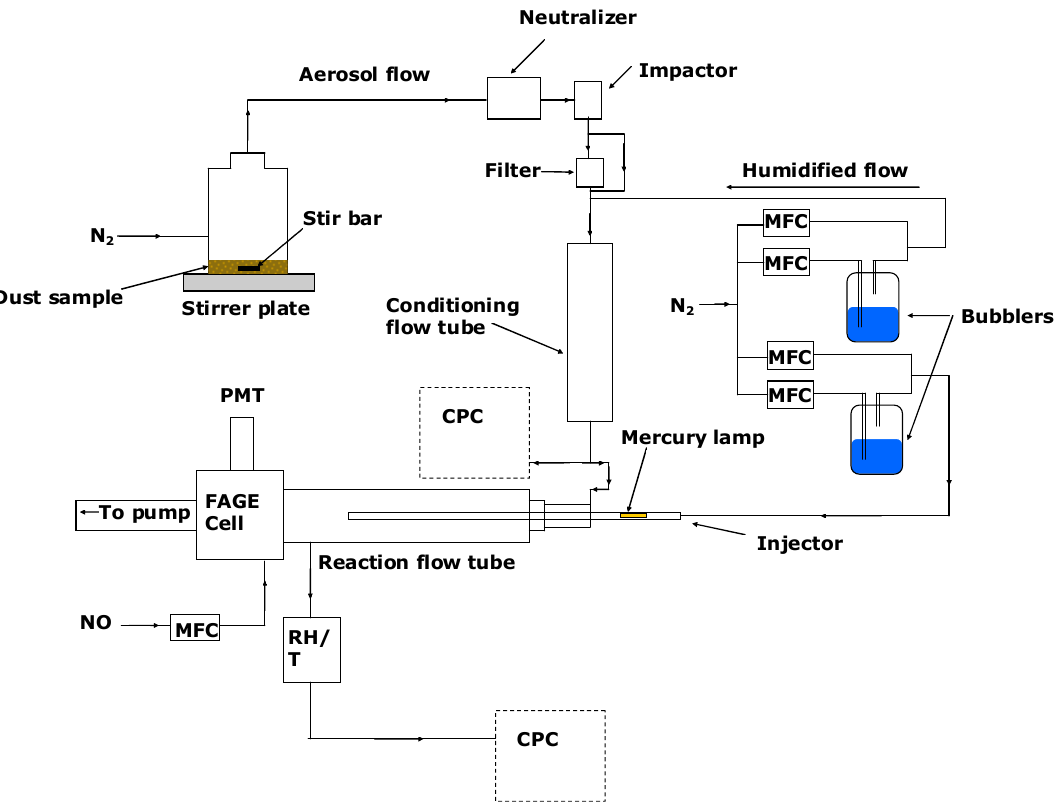
Figure 1. Schematic of the experimental setup showing the dust aerosol generator, conditioning system, aerosol flow tube and HO 2 detection system. Key: MFC – mass flow controller; CPC – condensation particle counter; PMT – photomultiplier tube; RH/T – relative humidity and temperature probe; FAGE – fluorescence assay by gas expansion. Dotted lines represent the two possible positions in which the CPC was placed. When measurements were made with the aerodynamic particle sizer and scanning mobility particle sizer, these were placed in the CPC positions.